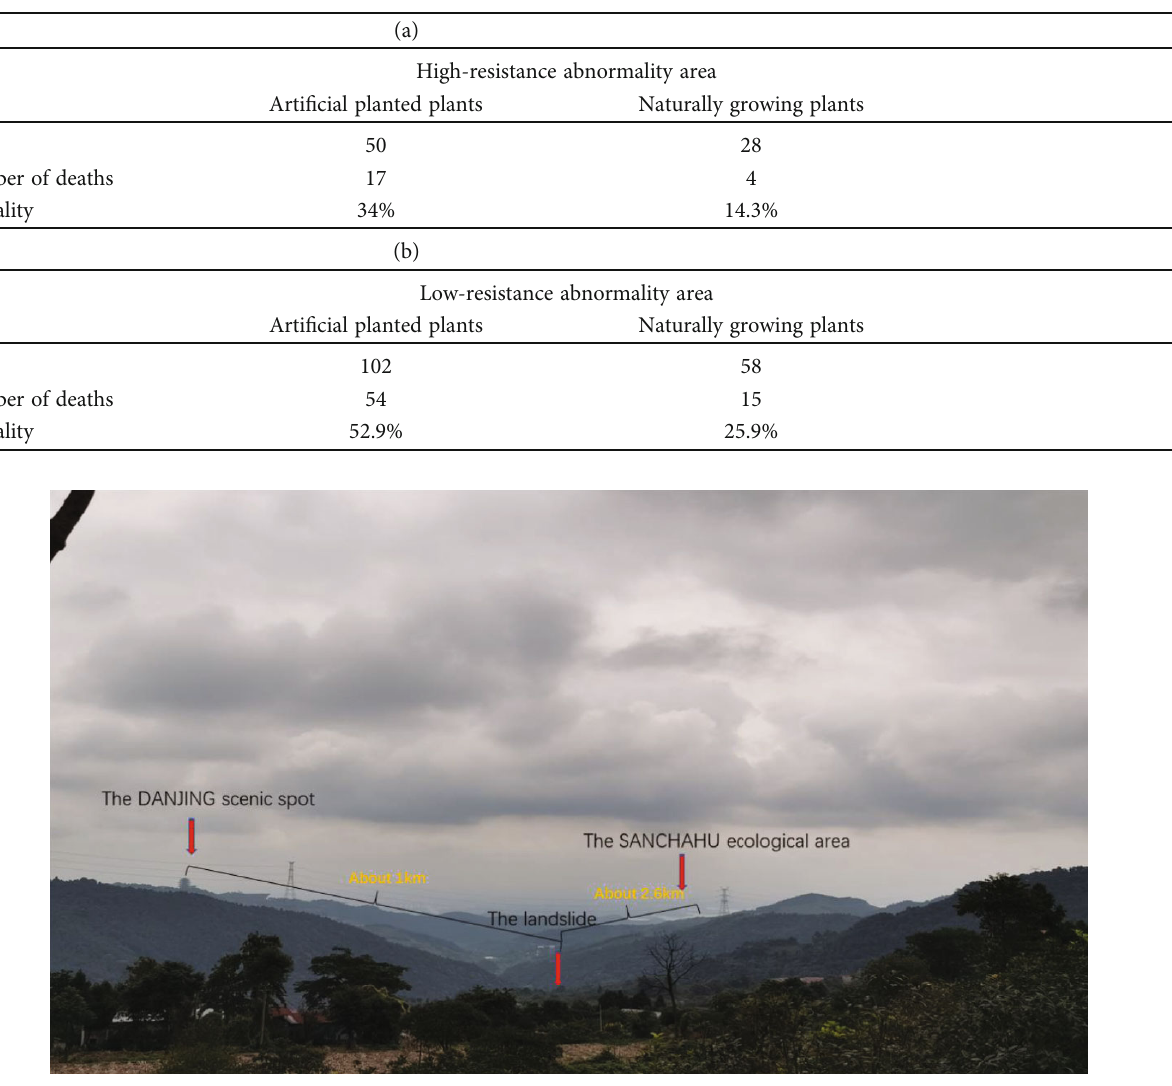
Table 5: The growth of plants in electrical anomaly on the landslide